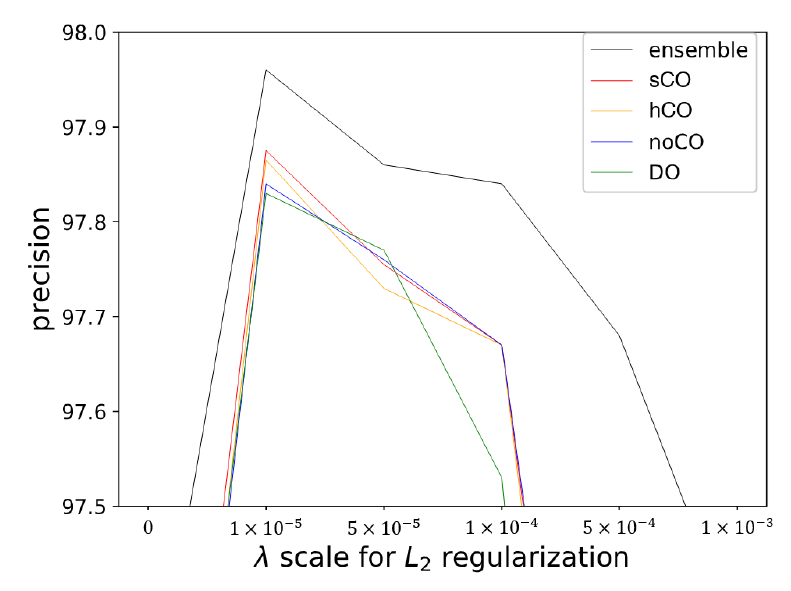
Figure 4. Achievable best performance of Cost-Out under L 2 regularization and batch normalization. (sCO: soft Cost-Out, hCO: hard Cost-Out, DO: dropout, noCO: without